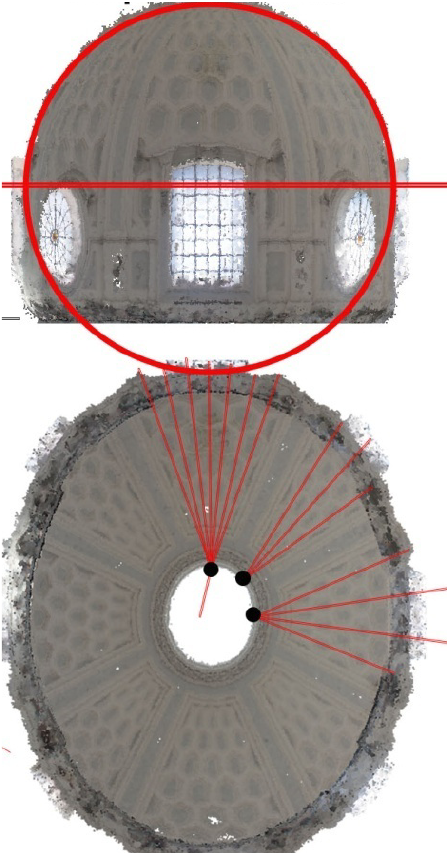
Figure 14. Dome of Padri della Missione in Naples. Coffers layout study.